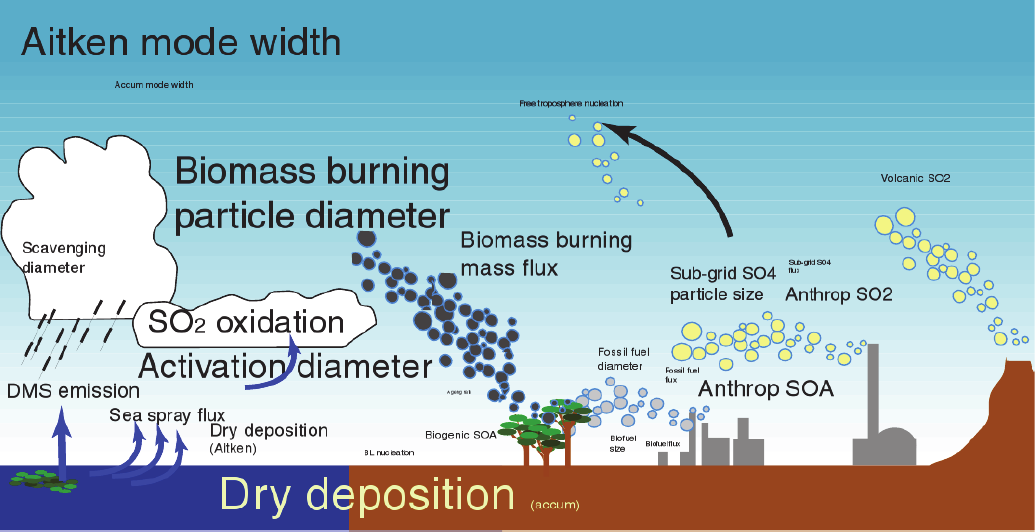
Fig. 11. Schematic showing the relative importance of the uncertain parameters for CCN. The size of the font is in direct proportion to the global and annual mean relative uncertainty.